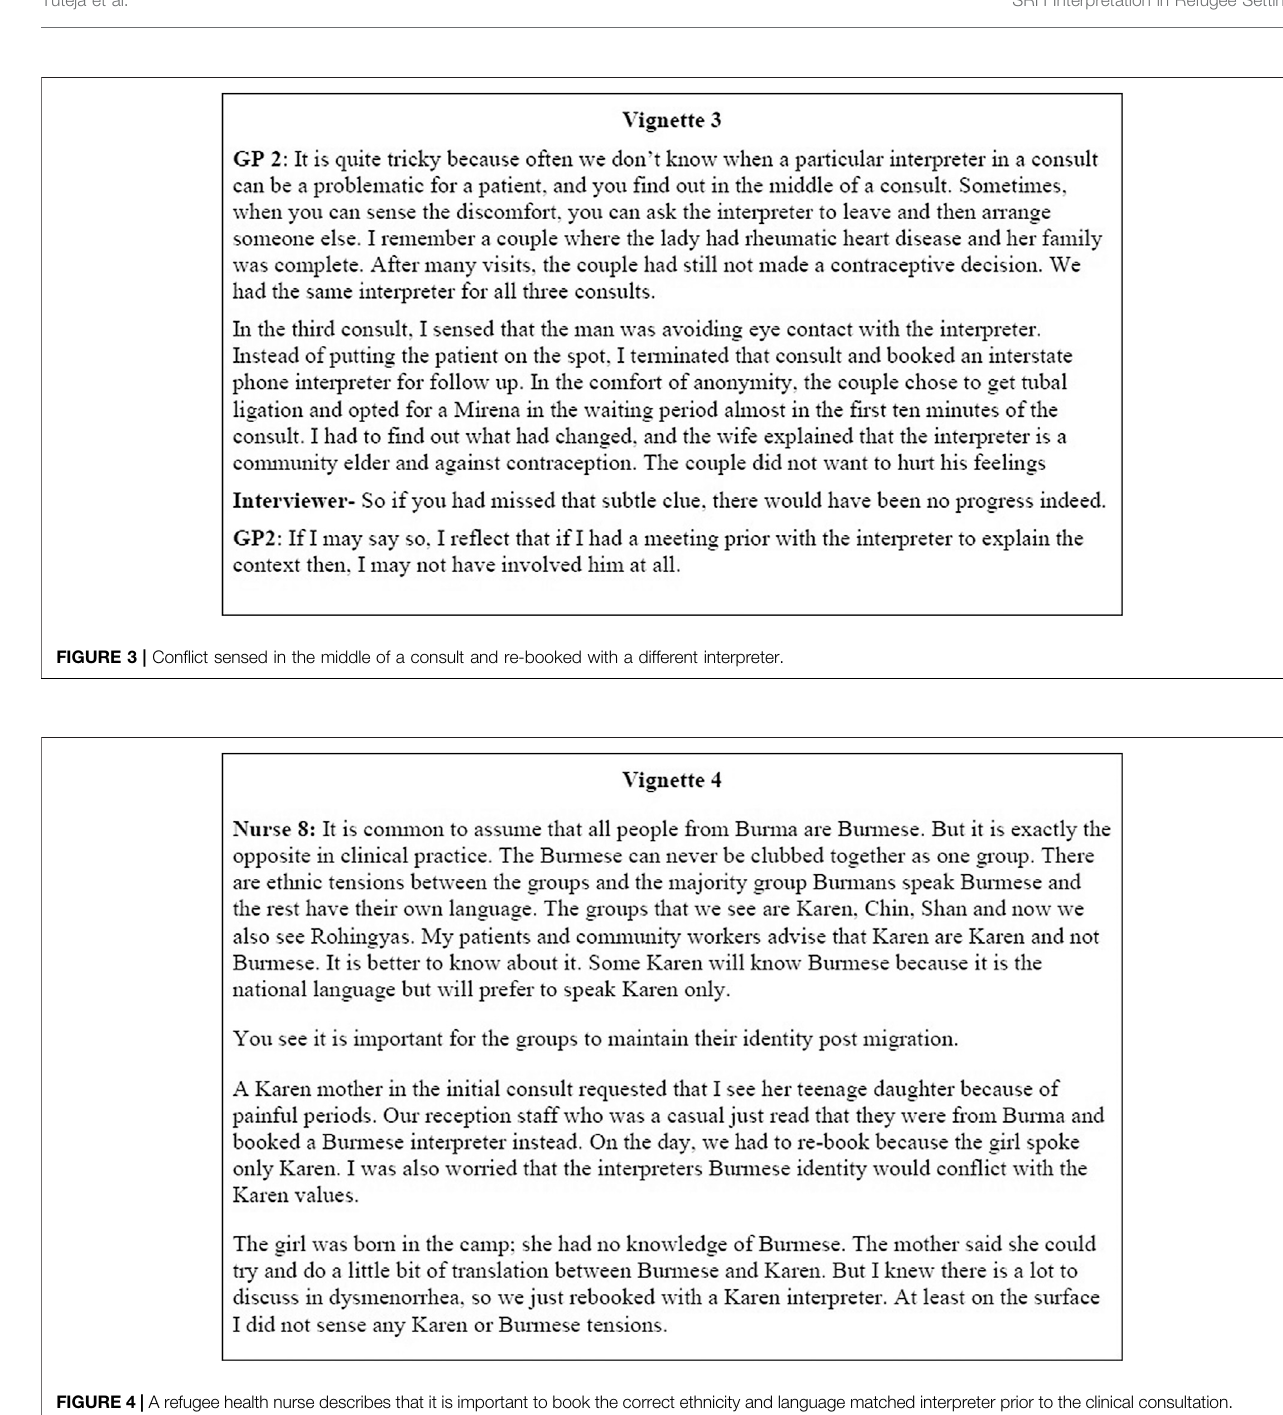
Frontiers in Communication |